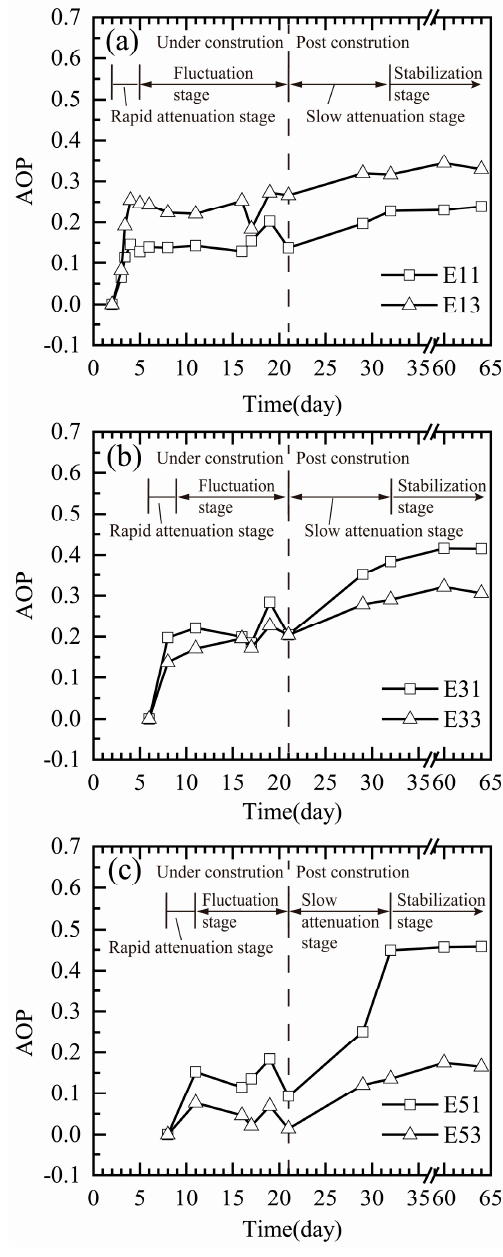
Figure 7. Time series of the lateral earth pressure attenuance at two monitoring points: ( a ) Below the surface at 1 m; ( b ) below the surface at 3 m; and ( c ) below the surface at 5 m. Table 1. The ratio of the attenuance of the lateral earth pressure (AOP) after rapid attenuation to the AOP of the stabilization stage.